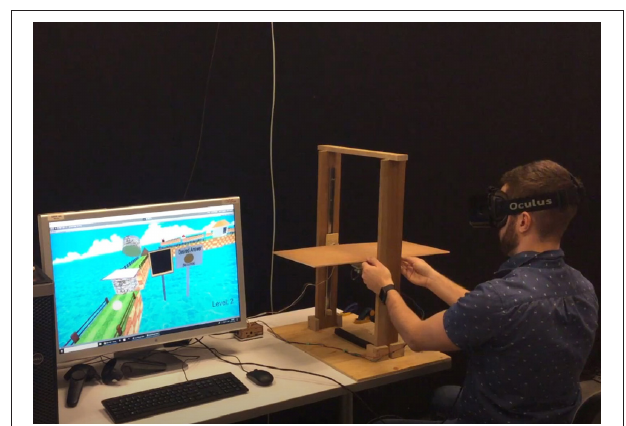
FIGURE 2 | VR-TEI intervention